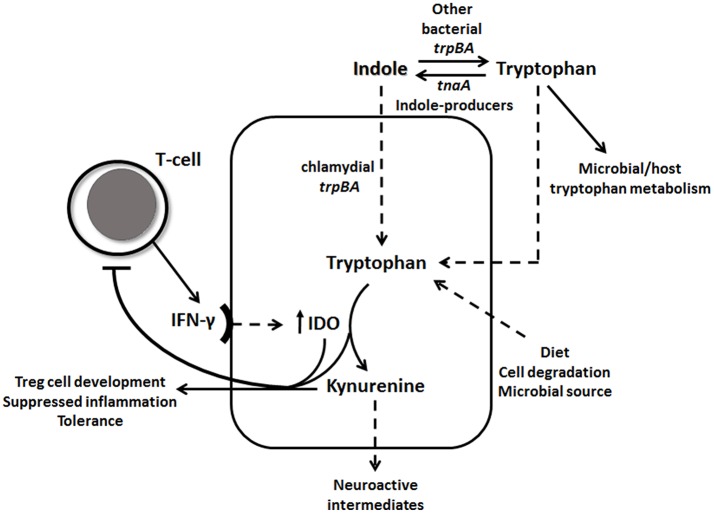
IFN-γ-tryptophan-kynurenine and indole pathways. IFN-γ induces IDO1 levels, which catabolizes tryptophan through the kynurenine pathway. Tryptophan depletion and high levels of kynurenine down-regulates IFN-γ activity. Chlamydial tryptophan synthase gene (trpBA) converts available indole back to tryptophan, as well as other vaginal tract bacterial trpBA. Indole-producing bacteria can synthesis indole from tryptophan using tnaA gene. Tryptophan can be accumulated in the epithelial cell in many ways, such as through diet, cell degradation and microbial source.